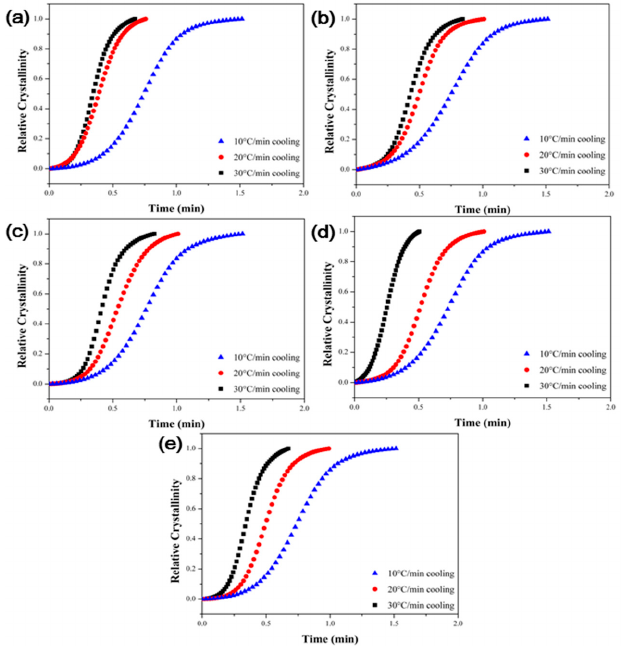
Figure 9. Plots of relative crystallinity versus time of the PPS/MWCNTs composites at different cooling rates. ( a ) Neat PPS, ( b ) PPSP1, ( c ) PPSA1, ( d ) PPSHP1, and ( e ) PPSS1.